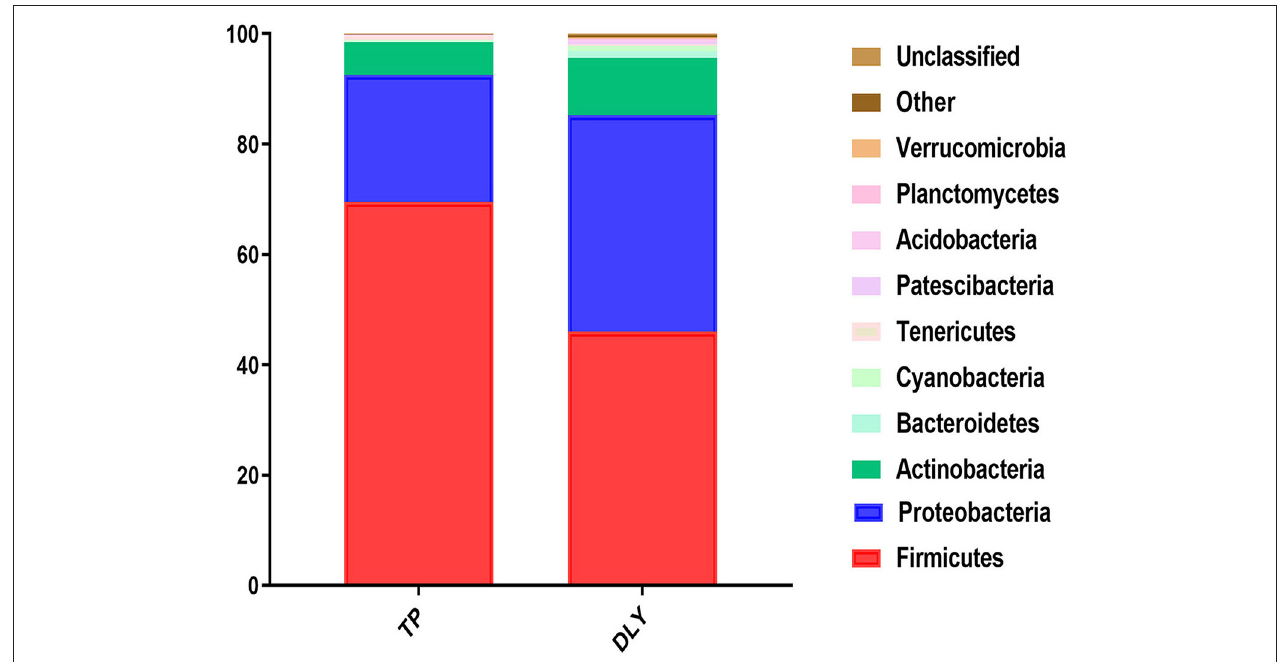
FIGURE 3 | Relative jejunal abundance at the phylum level in TP and DLY pigs.